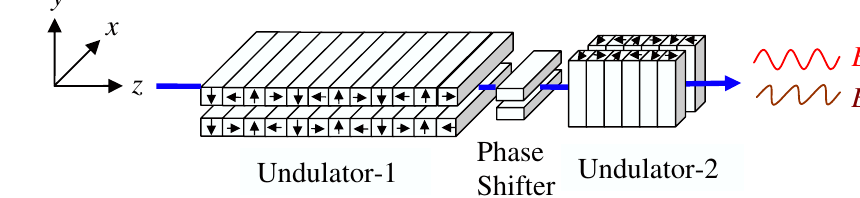
FIG. 1. (Color) Schematic of the crossed undulator for polarization